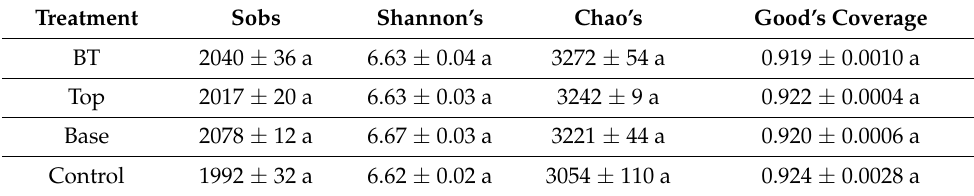
Table 5. Bacterial community diversity indexes in different treatments and the